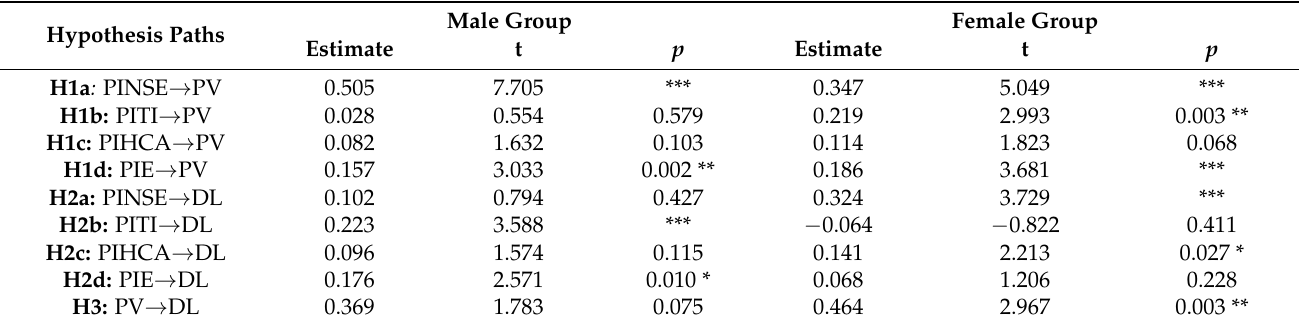
Table 6. The moderating influence of